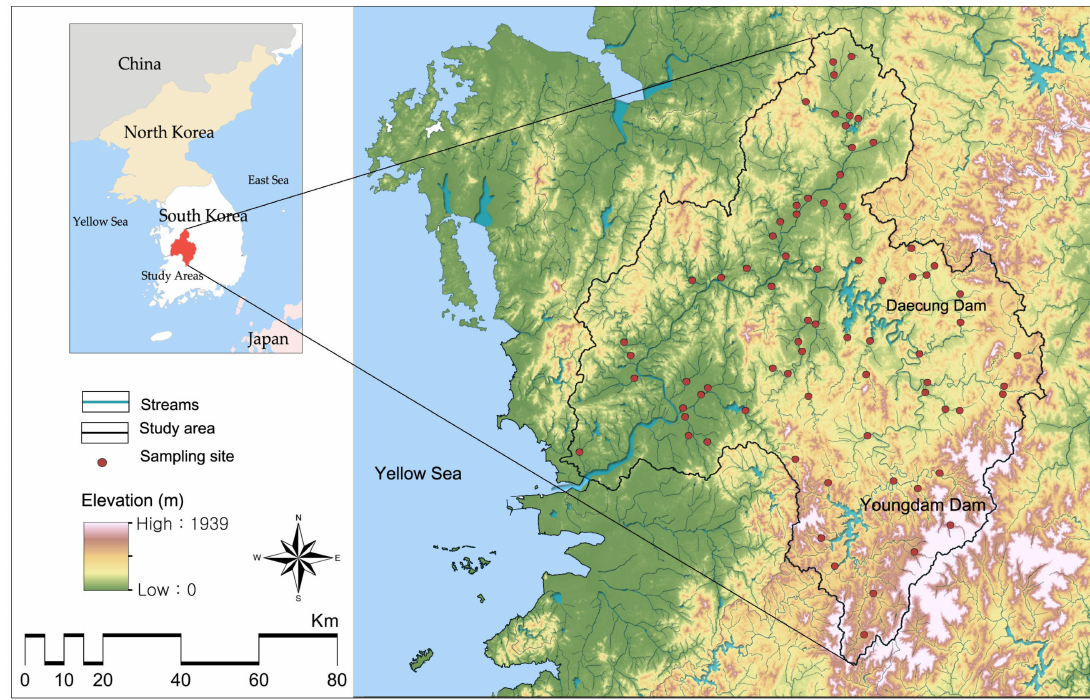
Figure 1. Geum River national watershed management region, topography, and sampling sites in the National Aquatic Ecological Monitoring Program in